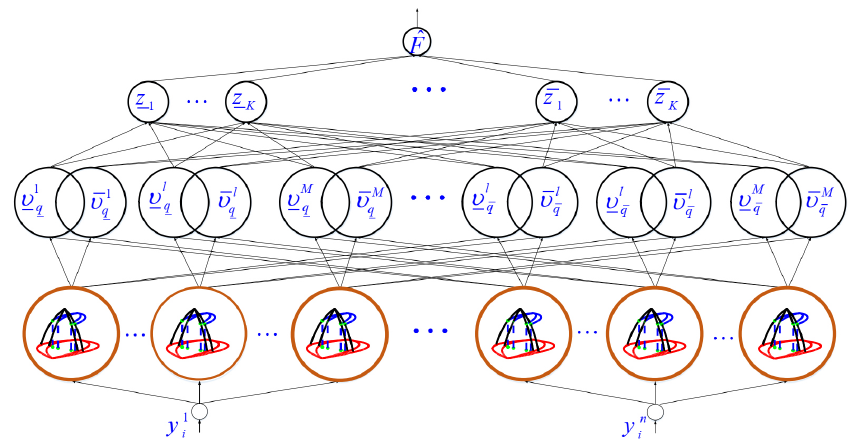
Figure 3. General view on T3FLS. (1) The inputs of r - th T3FLS are x i , i = 1, ..., n . (2) The upper/lower memberships of ˜ ϑ j